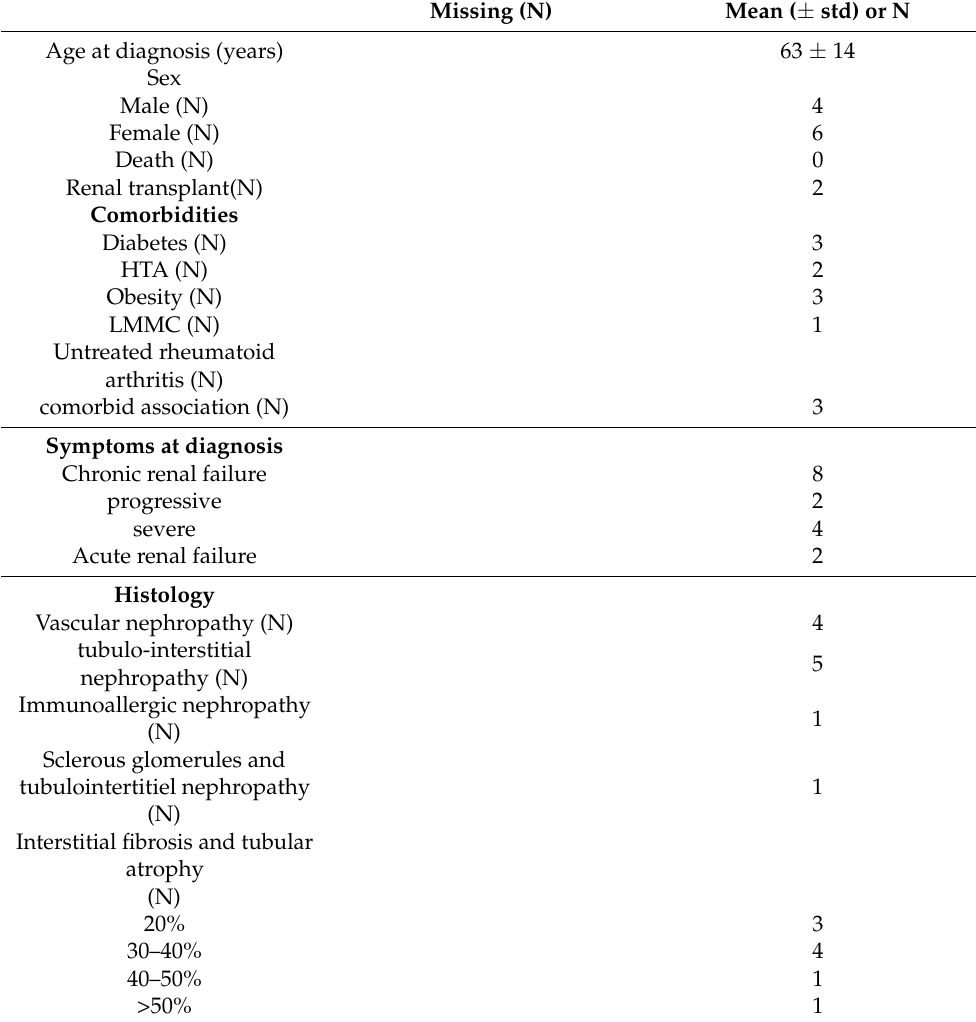
Table 10. Description of the cohort of renal fibrosis. N is corresponding to the number of patients. Missing (N) Mean ( ± std) or